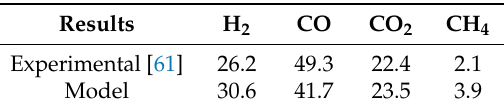
Table 5. Comparison between experimental data and model results at the reformer exit. The data are reported in mol % N 2 free and dry